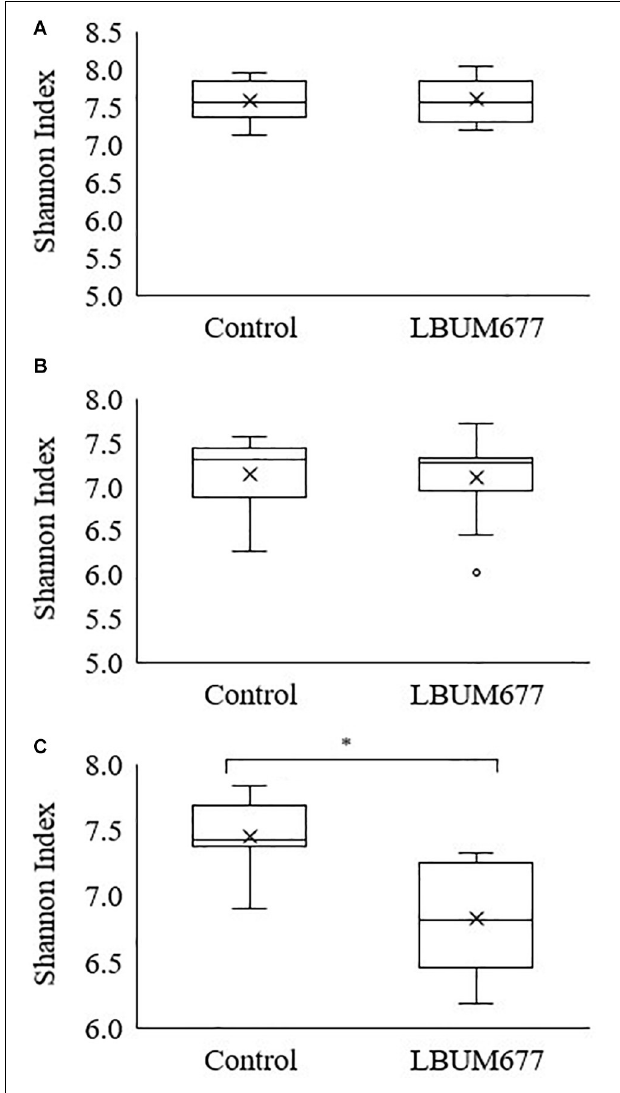
FIGURE 4 | Temporal and treatment variations of alpha-diversity metric in the bacterial microbiome of three oil-producing crops. Alpha-diversity metric (Shannon’s index) of temporal variations amongst treatments at (A) 30 days, (B) 60 days, and (C) 90 days post-inoculation. Kruskal-Wallis pair-wise test was used to assess statistical significance between treatments (* p <